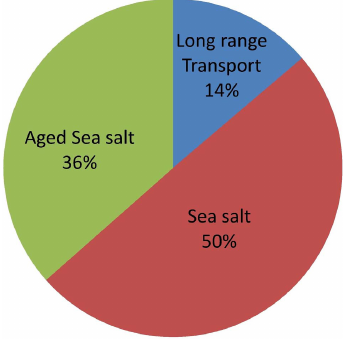
Figure 12. Average contribution of each source to the total analyzed